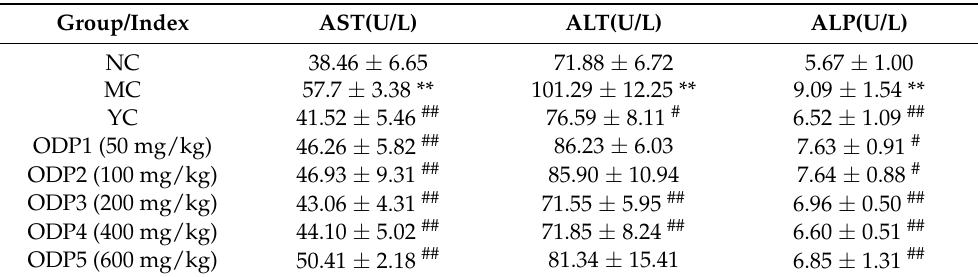
Table 3. Dose–response relationship of ODP with AST, ALT, and ALP in mice. Group/Index AST(U/L)